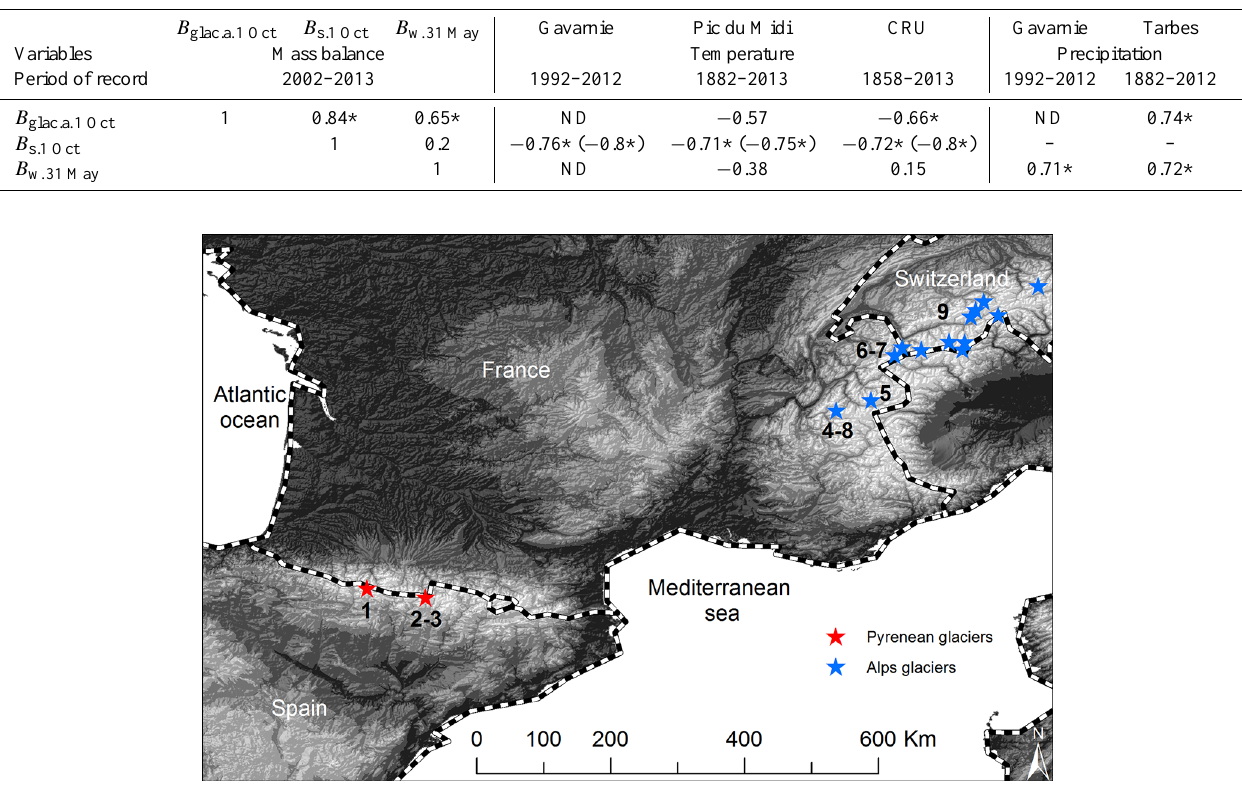
Figure 5. Location of the glaciers used for comparison with Ossoue Glacier